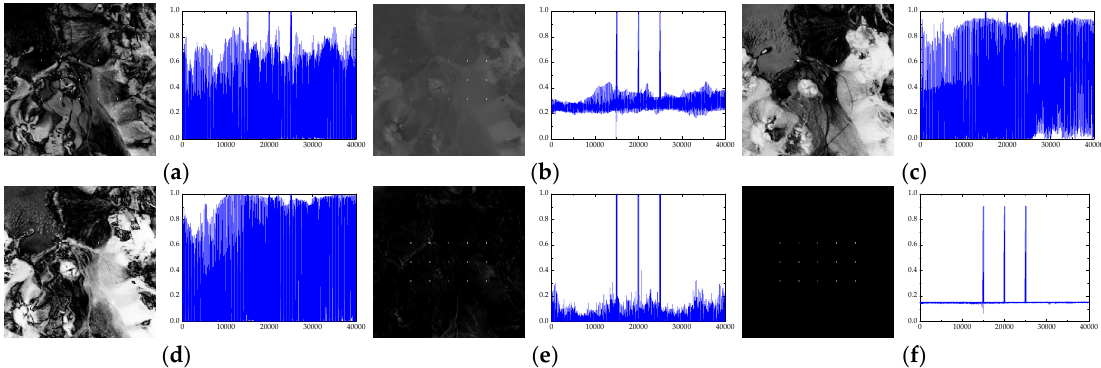
Figure 6. Detection maps and target detection test statistic plots of the AVIRIS LCVF dataset. ( a ) ACE; ( b ) OSP; ( c ) LMNN; ( d ) NCA; ( e ) ITML; ( f ) ITML–ALC.